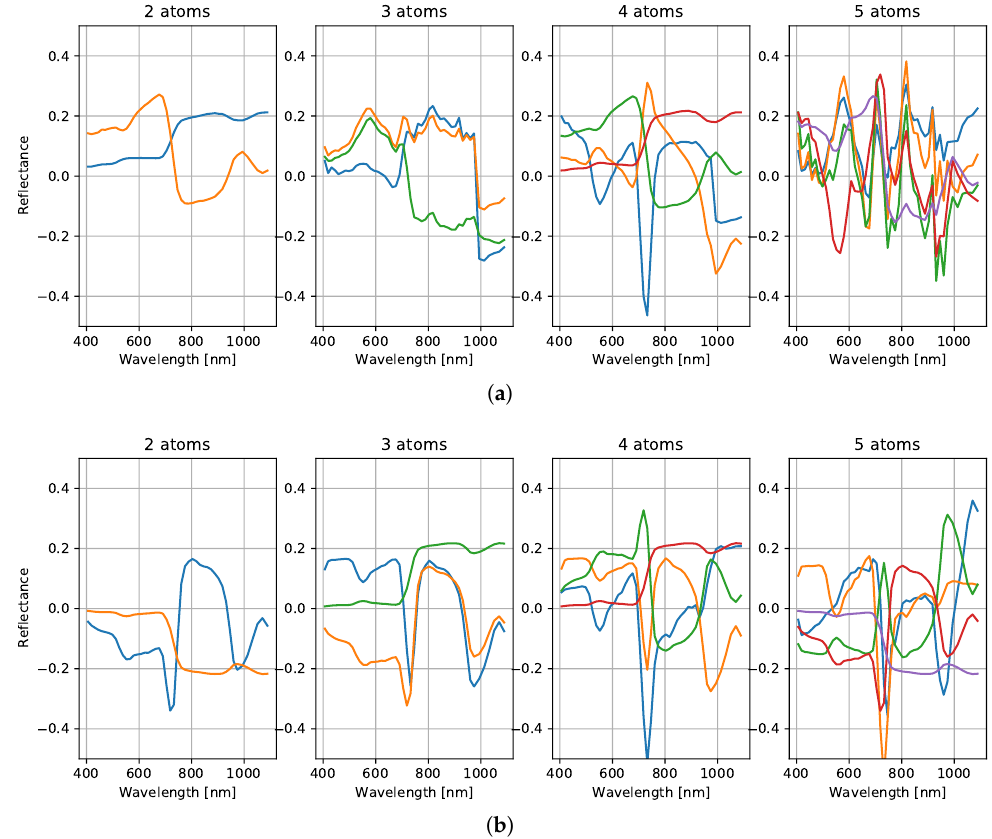
Figure 4. Atoms trained at different dictionary sizes and on different training sets. ( a ) Trained on Air_Full. ( b ) Trained on Ground_Full.